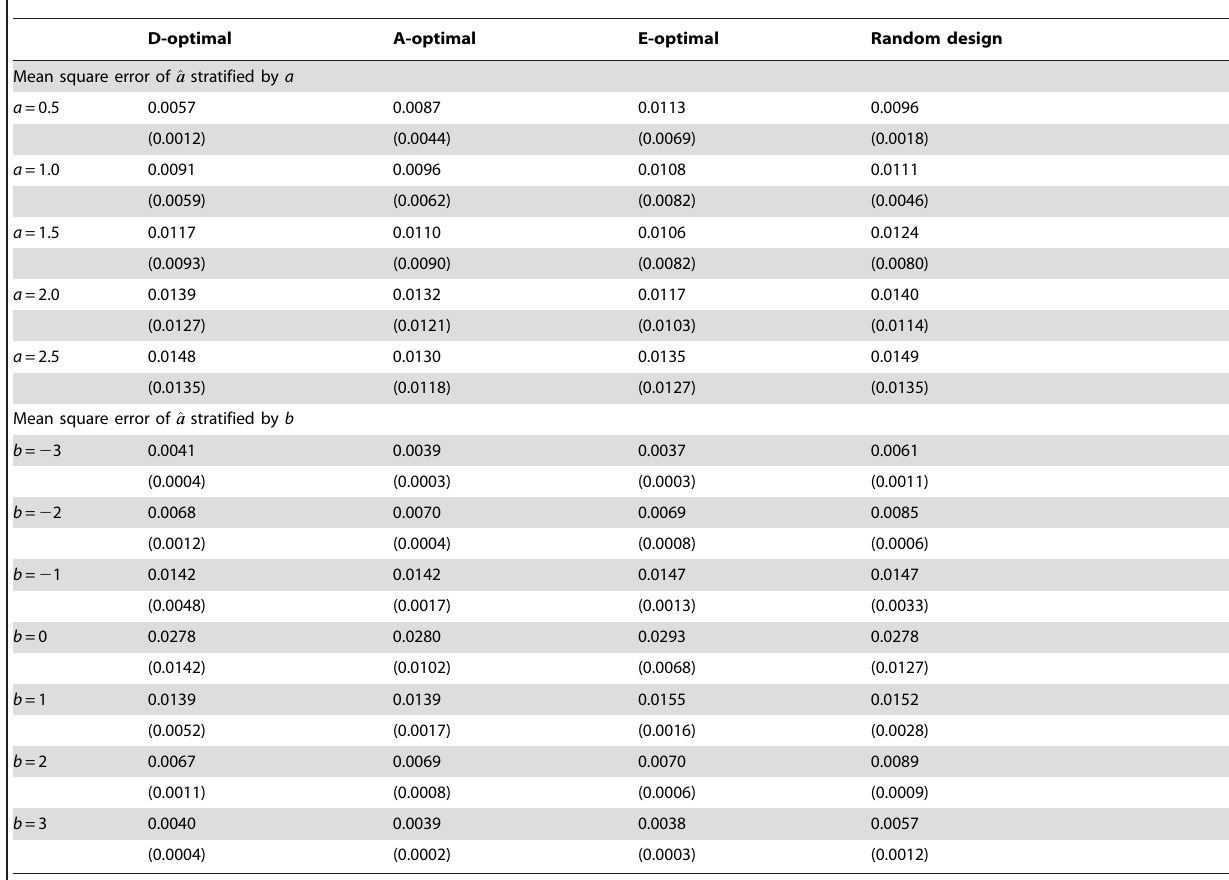
Table 2. Mean square error of ^ aa